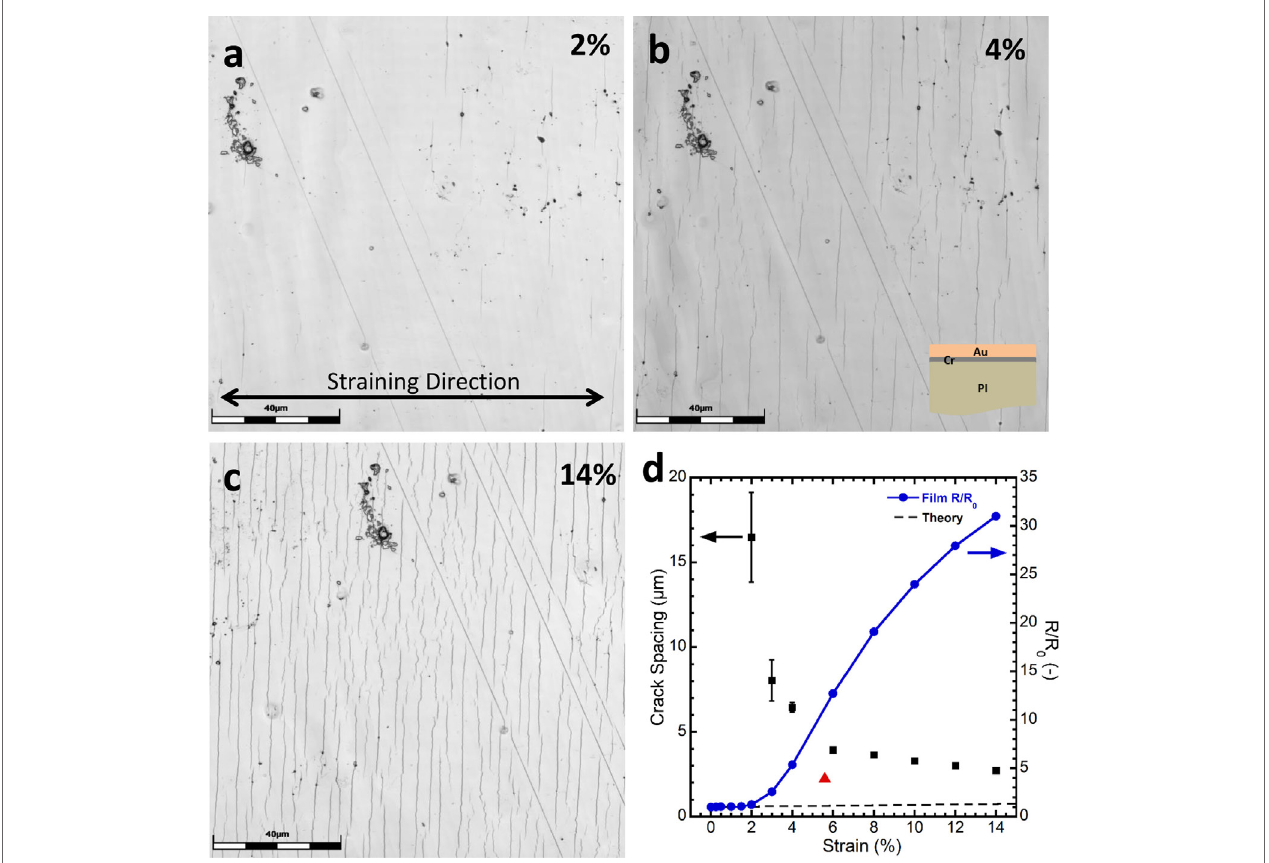
FigUre 5 | example of an in situ fragmentation test with clsM and 4PP on a 50-nm au film with a 10-nm cr adhesion layer . (a) At 2% strain, cracks have initiated and caused an increase in the resistance. (B) Same area of film after 4% strain, (c) after 14% strain and crack saturation. (D) Corresponding crack spacing (black squares) and R/R 0 response (blue circles, connecting line has no mathematical meaning) illustrating the correlation between crack spacing and COS as well as resistance recovery upon unloading (red triangle). Scale bars in (a–c) are 40 μ m (color